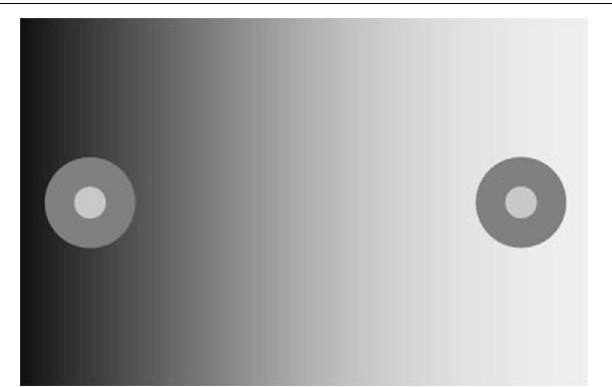
FIGURE 2 | Perceptual edge integration demo. The disks and annuli on the two sides of the display have the same luminance, so the luminance ratio at the disk/annulus edge is the same on the two sides. The shallow luminance gradient across the background field produces outer annulus edge ratios of opposite sign on the two sides of the display. The outer annulus edge on the right signals to the brain that the annulus is darker than the background field; whereas, the outer edge on the left signals that the annulus is lighter than the background field. The key observation is that the polarity of this edge influences the appearance of both the annulus and the disk that is embedded inside it. The disk appearance cannot be explained by a filling-in mechanism that diffuses from the outer annulus border and is stopped by the disk/annulus edge. The filling-in signal must be able to reach the region of the disk. This fact is explained in the model by the mechanism of cortical edge